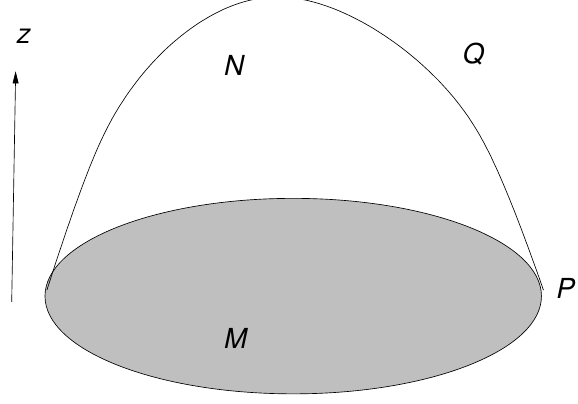
Figure 1 . BCFT on M and its dual N